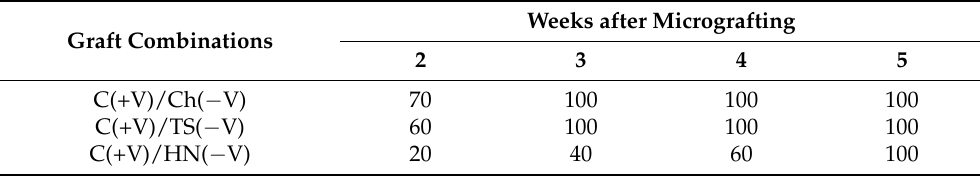
Table 2. GLRaV-3 infected percentages (%) of different graft combinations at different weeks. Weeks after Micrografting Graft Combinations 2 3 4